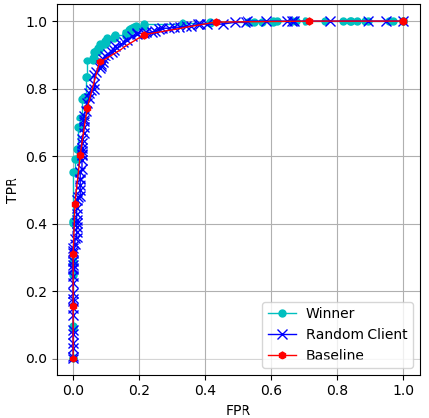
Figure 11. Graph of the ROC and the AUC.